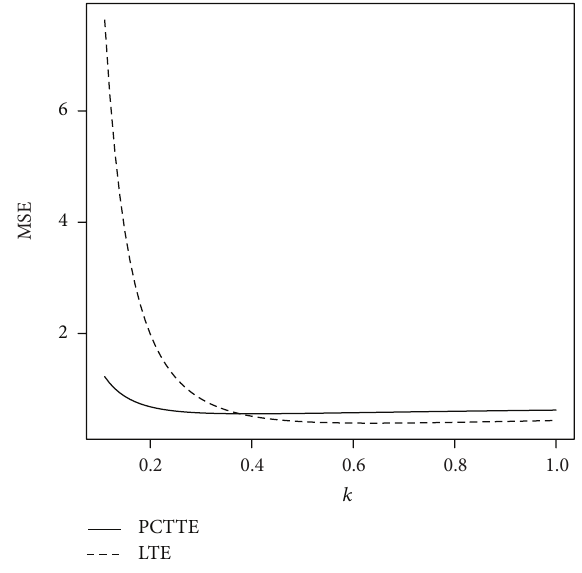
Figure 8: The MSE values of LTE and PCTTE when 𝑑 = 0.3 .